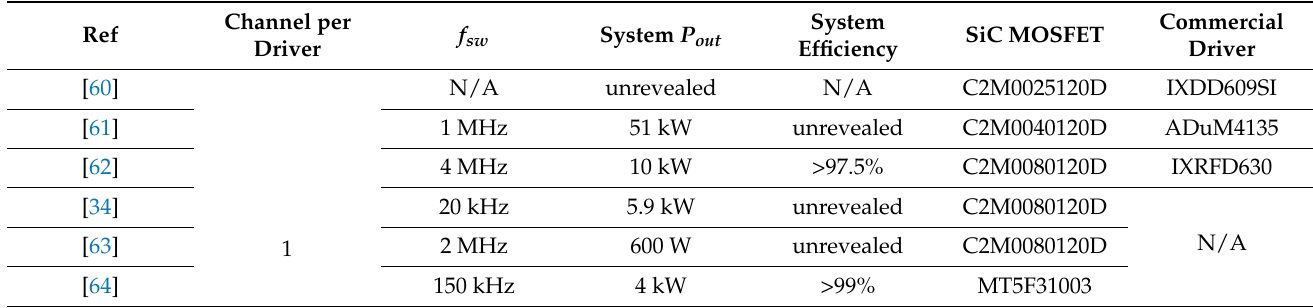
Table 39. Reviewed SiC MOSFET driving